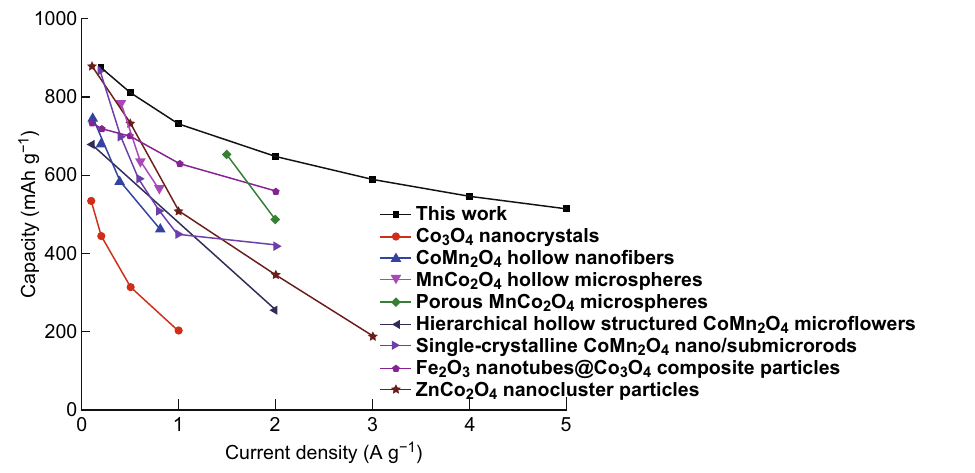
Fig. 8 Comparison of the lithium storage properties of the MnO/CoMn 2 O 4 ⊂ GN to similar anode materials reported in other